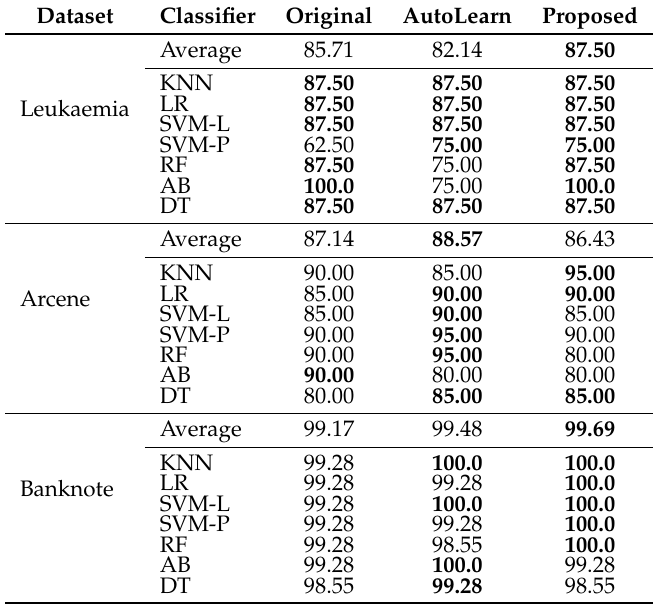
Table 9. Performance comparison in terms of classification accuracy